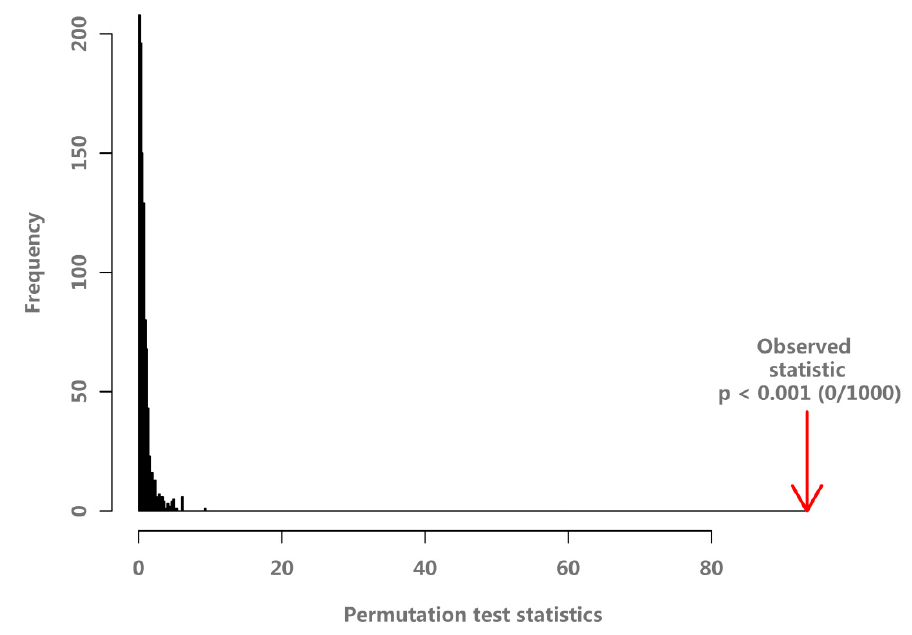
Figure 9. The PLS ‐ DA permutation test for serum data.